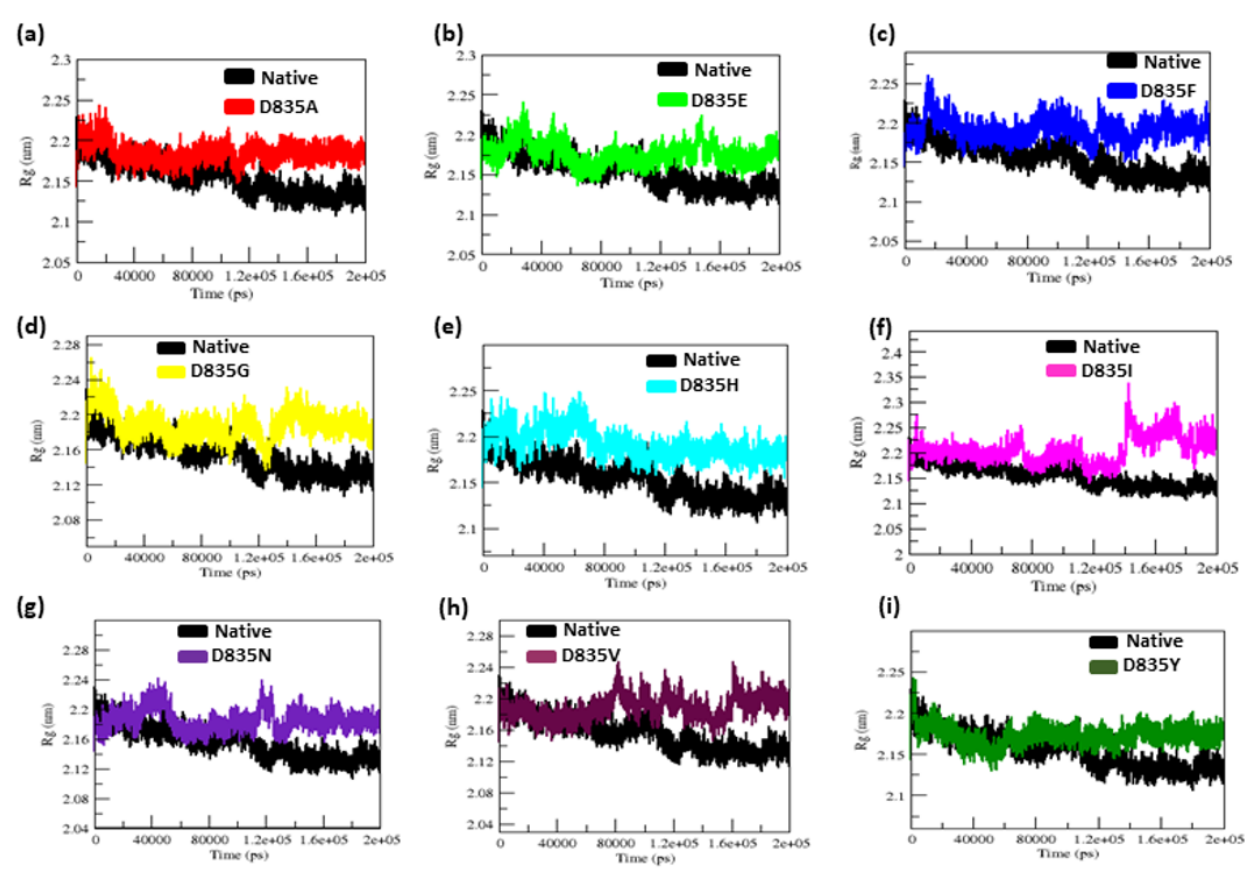
Figure 3. The native and mutant FLT3 protein structures compactness analysis by Radius of gyration for the period of 200 ns. ( a ) Native vs. D835A; ( b ) Native vs. D835E; ( c ) Native vs. D835F; ( d ) Native vs. D835G; ( e ) Native vs. D835H; ( f ) Native vs. D835I; ( g ) Native vs. D835N; ( h ) Native vs. D835V; ( i ) Native vs. D835Y.